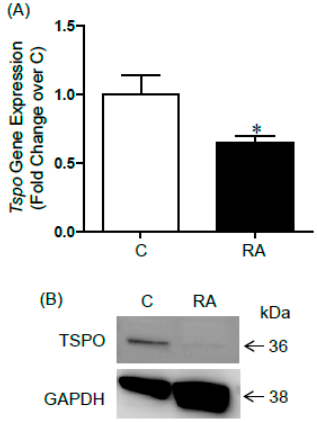
Figure 2. Changes in TSPO expression in differentiating F9 embryonal carcinoma cells. ( A ) Tspo mRNA expression in F9 cells treated with or without RA (10 − 7 M) for 24 h in medium supplemented with 10% FBS. Results shown are from 5 independent experiments, with each treatment done in duplicate wells, and are plotted as mean ± SEM. * p -value < 0.05; ( B ) immunoblot analysis of TSPO protein expression in F9 cells treated with or without RA (10 − 7 M) for 72 h. TSPO 36 kDa dimer band is observed. GAPDH: Loading control. A representative immunoblot is shown.